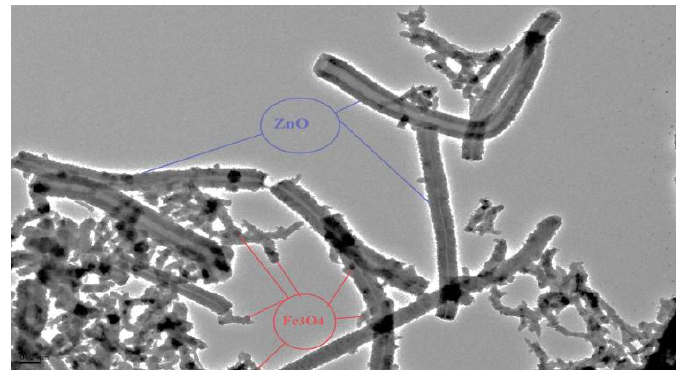
Figure 3. Transmission electron microscopy (TEM) images of the magnetic ZnO nanotubes.